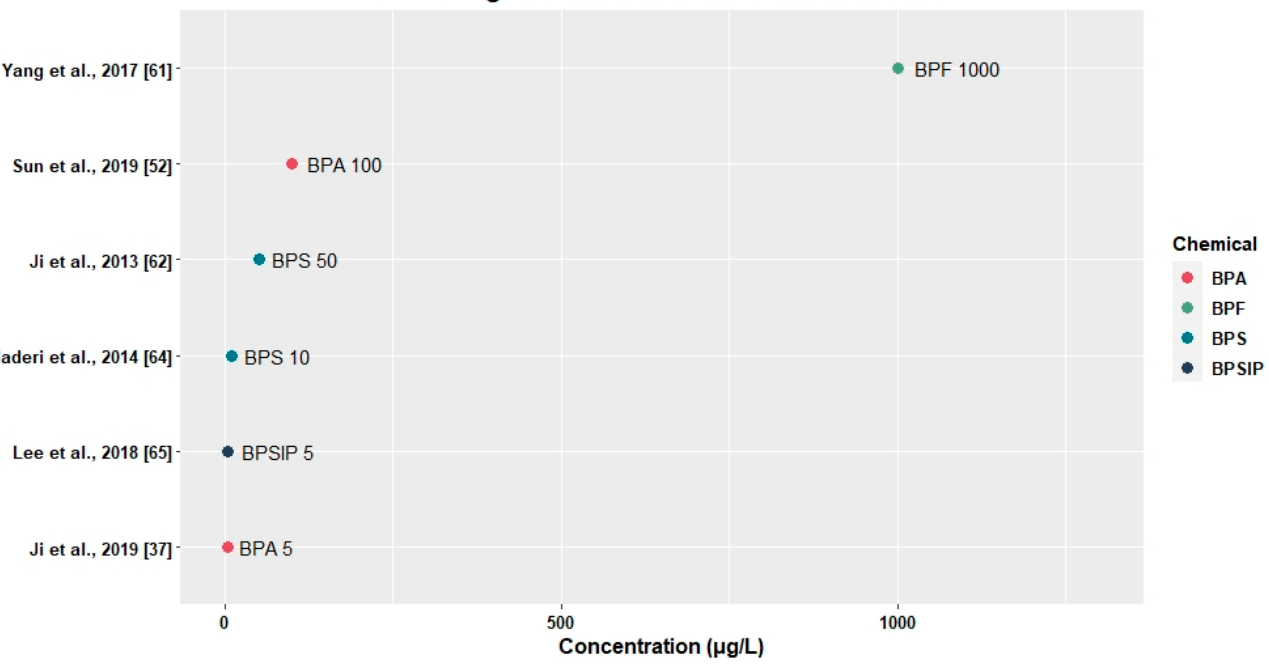
Figure 2. Lowest observed adverse effect level (LOAEL) of gonadosomatic index (GSI) in male zebrafish exposed to BPA, BPF, BPS, and BPSIP.